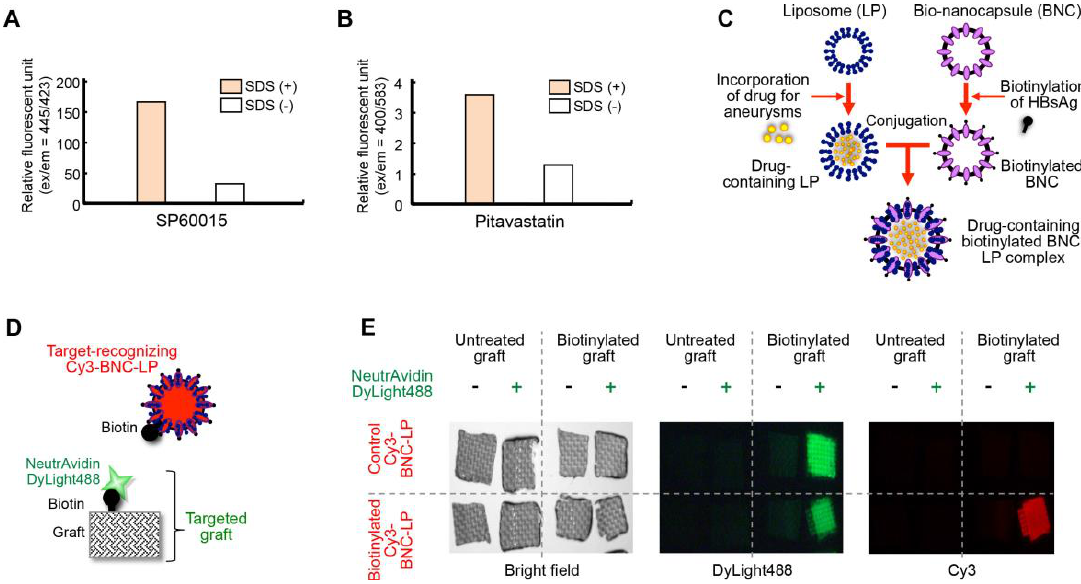
Figure 4. Development of the bio-nanocapsule-liposome (BNC-LP) complex. ( A, B ) Incorporation of ( A ) SP60015 and ( B ) pitavastatin into liposomes. Successful incorporation was determined by measuring drug autofluorescence, before and after liposomes were dissolved with sodium dodecyl sulfate (SDS) treatment. ( C ) Schematic diagram illustrates the preparation of the drug-containing biotinylated BNC-LP complex. The liposome is an empty lipid micelle that can be filled with the desired drug. The bio-nanocapsule is a hollow sphere composed of hepatitis B virus surface antigen (HBsAg). Biotin reacted with HBsAg, then the BNC was conjugated to the LP. ( D ) Diagram shows the configuration of a BNC-LP complex labeled with Cy3. The attached biotin recognizes the neutravidin on the targeted graft. ( E , left) Bright field images show the woven polyester grafts used for the in vitro binding assay. (Middle) Fluorescence images show the binding of DyLight488-labeled neutravidin (green) to the biotinylated grafts. (Right) Fluorescence images show the binding of the biotinylated Cy3-labeled BNC-LP (red) to the neutravidin on the biotinylated grafts.